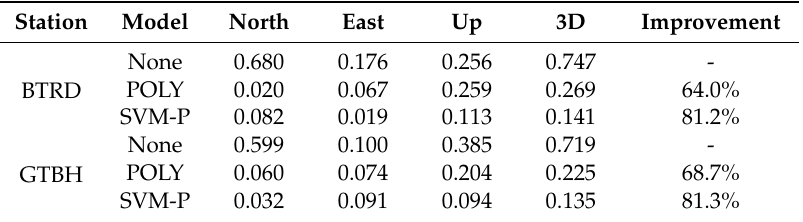
Table 3. Results of single-frequency PPP (RMS /